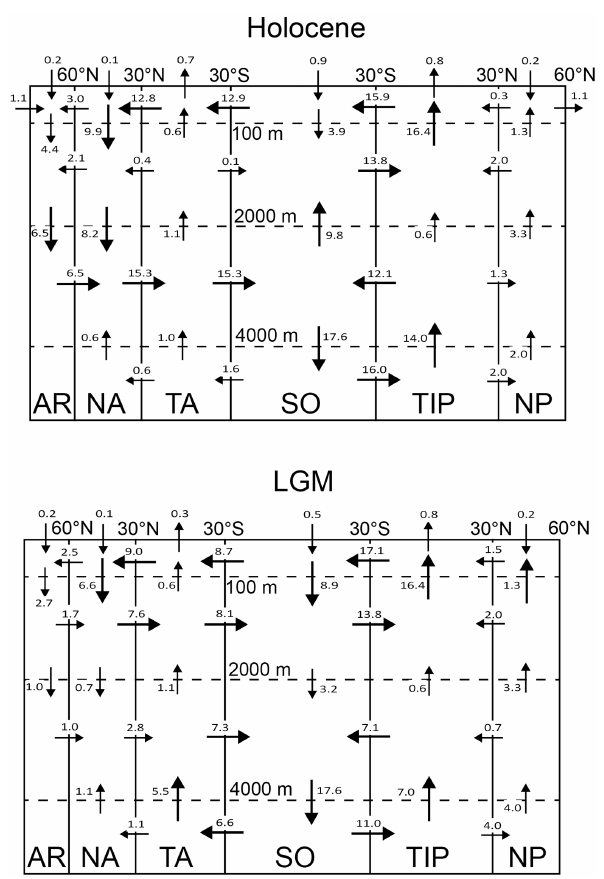
Figure 3. Model forcing related to sea-level change. (a) Eu- static sea-level (Waelbroeck et al., 2002; Stanford et al., 2011); (b) global ocean volume as calculated from eustatic sea-level and ocean bathymetry data (Eakins and Sharman, 2012); (c) salinity of global mean seawater as calculated from global ocean volume; (d) global burial rate of neritic carbonate as calculated from seafloor area at 0–50m water depth (Kleypas, 1997; Wallmann, 2014); (e– f) seafloor area at 0–100m and 100–2000m water depth calculated from sea-level and ocean bathymetry data (Eakins and Sharman, 2012); (g) exposed shelf area calculated from sea-level and ocean bathymetry data (Eakins and Sharman, 2012); (h) global rate of POC weathering calculated from exposed shelf area (Wallmann,